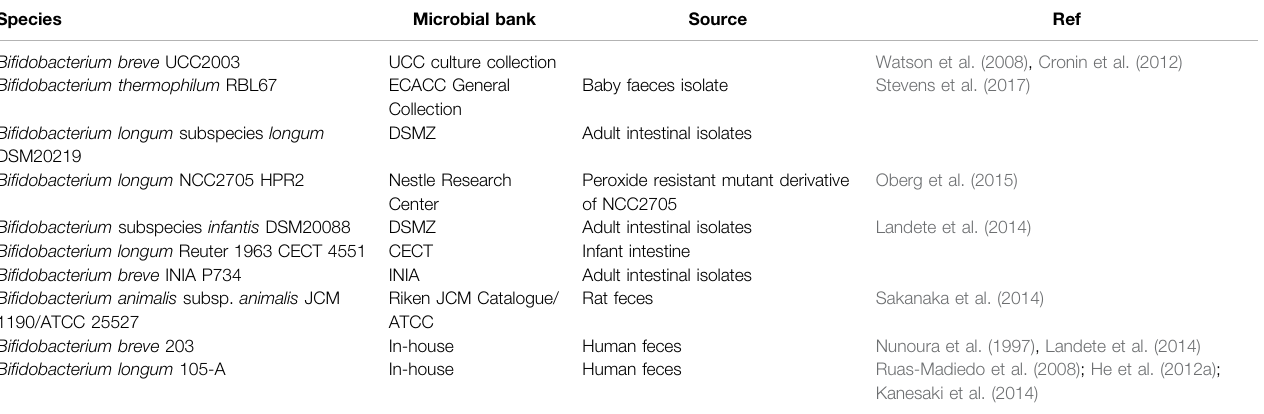
TABLE 2 | The various Bi fi dobacterium used as an engineering chassis.